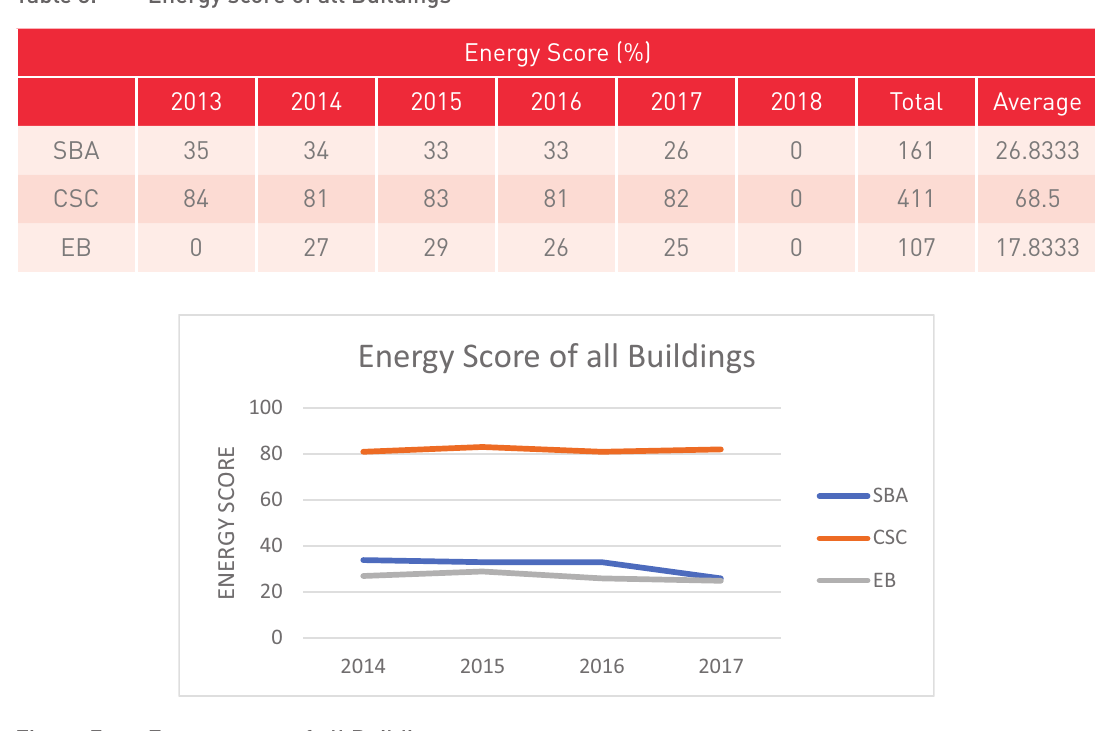
Figure 7. Energy score of all